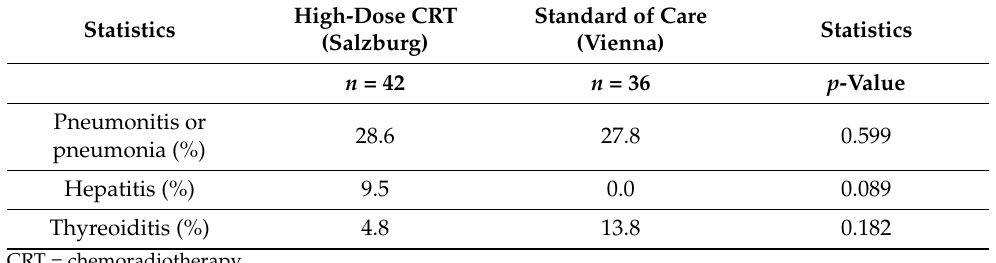
Table 3. Toxicity: pulmonary toxicity was equally distributed in both groups.